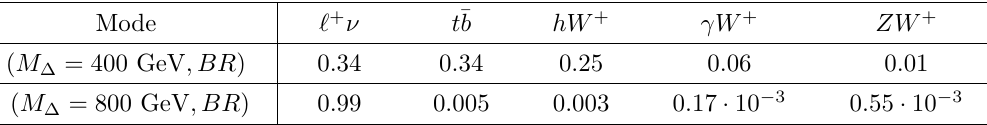
Table 3 . BRs of the H + decays with (cid:21) 4 = 0, where (cid:21) 1 = 2 : 5 for M (cid:1) = 400 GeV and (cid:21) 1 = 10 for M (cid:1) = 800 GeV are used.